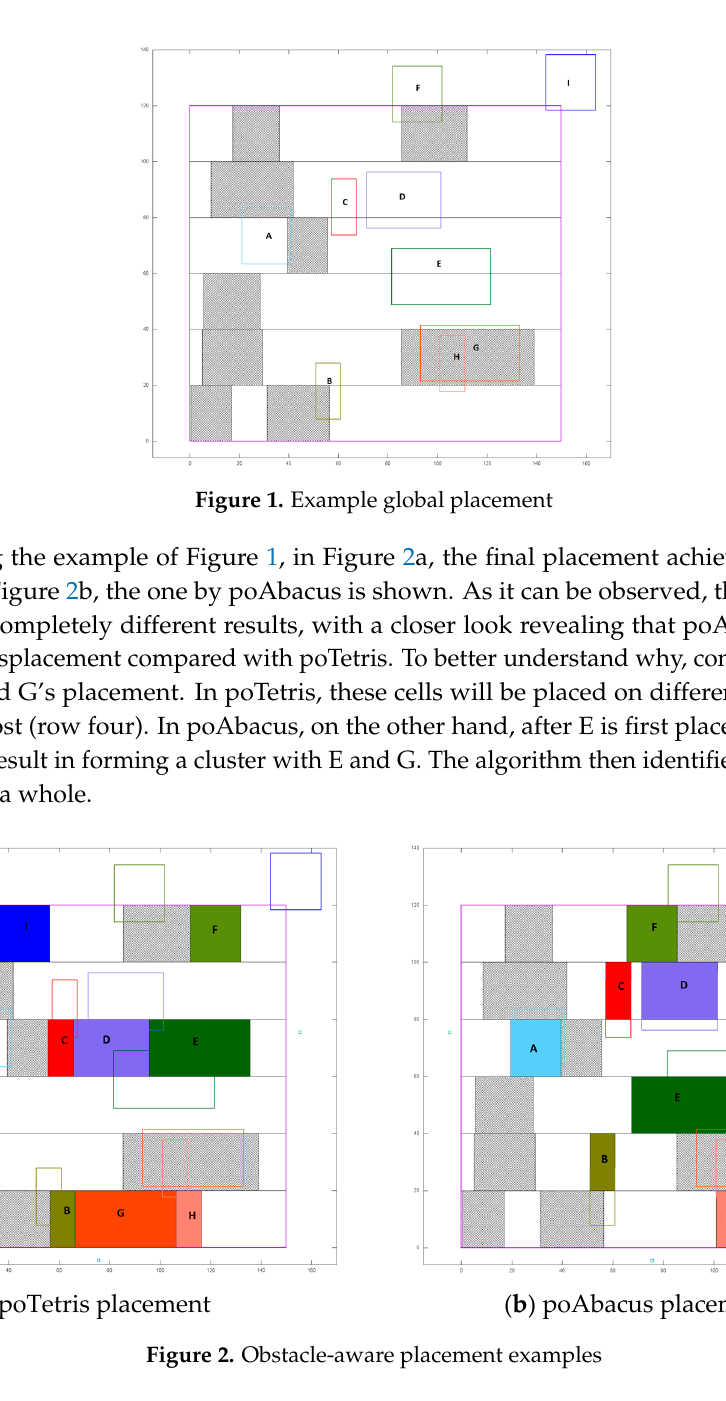
Figure 2. Obstacle-aware placement examples